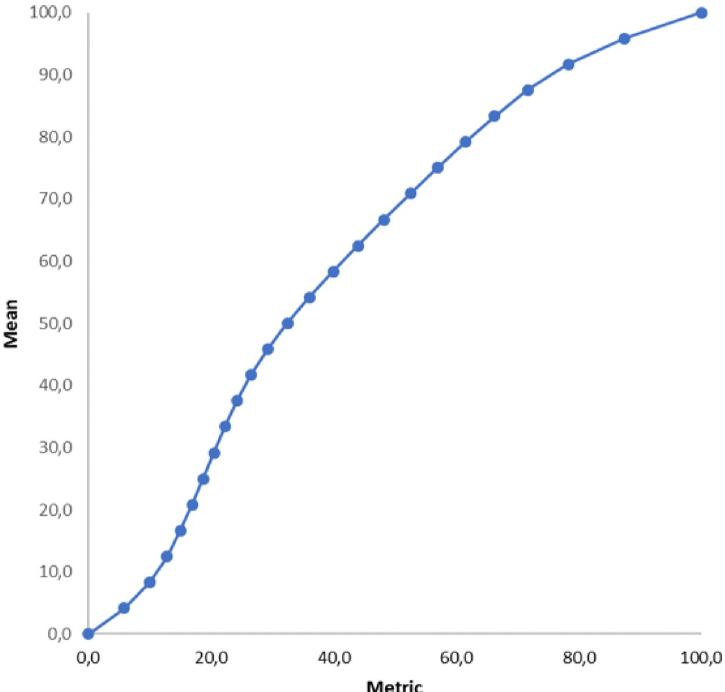
Fig 3. Comparison of the metric and mean score for the Workplace Social Capital scale of the COPSOQ III.